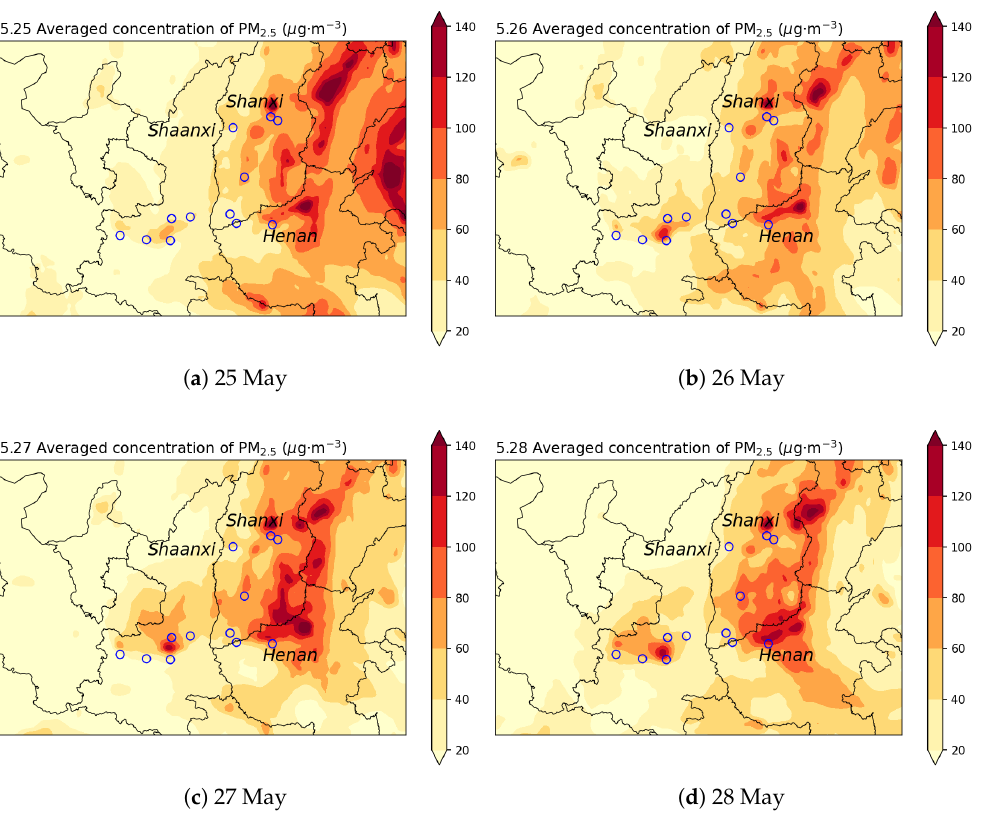
Figure 7. Spatial distributions of daily mean PM 2.5 on different days. Cities in Fenwei Plain are marked by blue